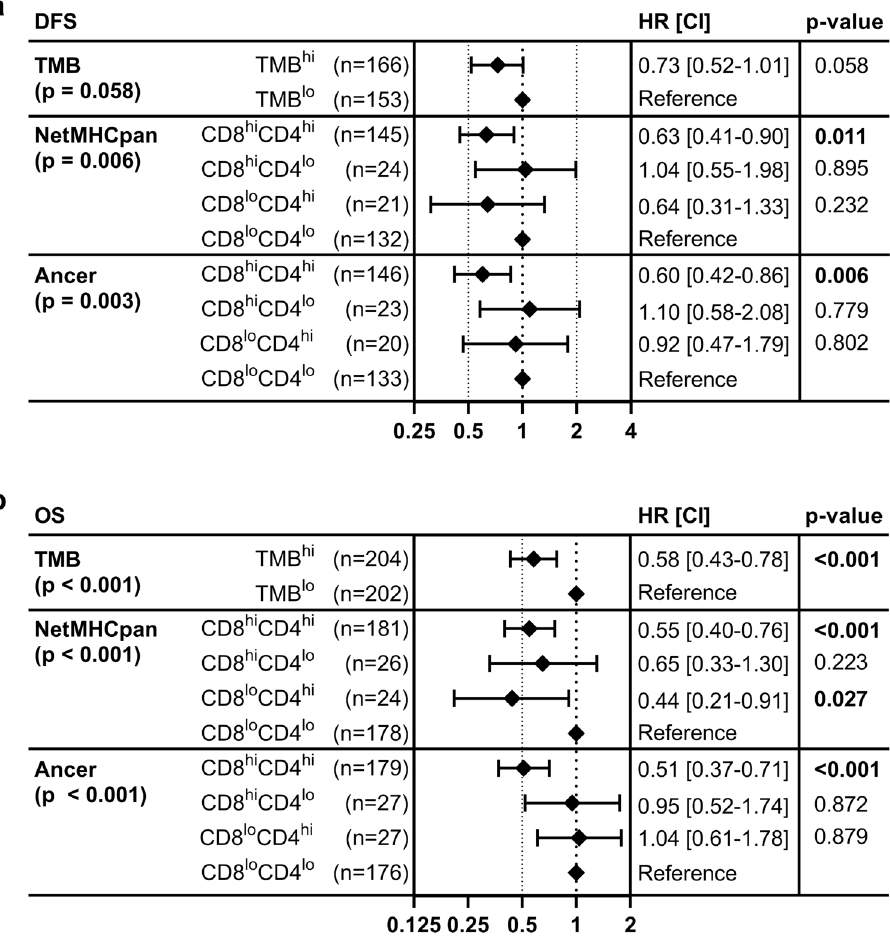
Figure 4. Univariate survival analysis forest plots. Univariate survival analyses were conducted separately for the TMB, NetMHCpan, and Ancer analyses while considering either disease free survival (DFS) ( a ) or overall survival (OS) ( b ). BLCA patients were separated based on their median TMB or neoepitope burdens. Association with DFS and OS is improved with Ancer compared to the other analysis. Hazard ratios (HR), confidence intervals (CI) and p -values ( p ) were calculated using univariate Cox proportional-hazard models. Overall log-rank p -value is provided for each model on the